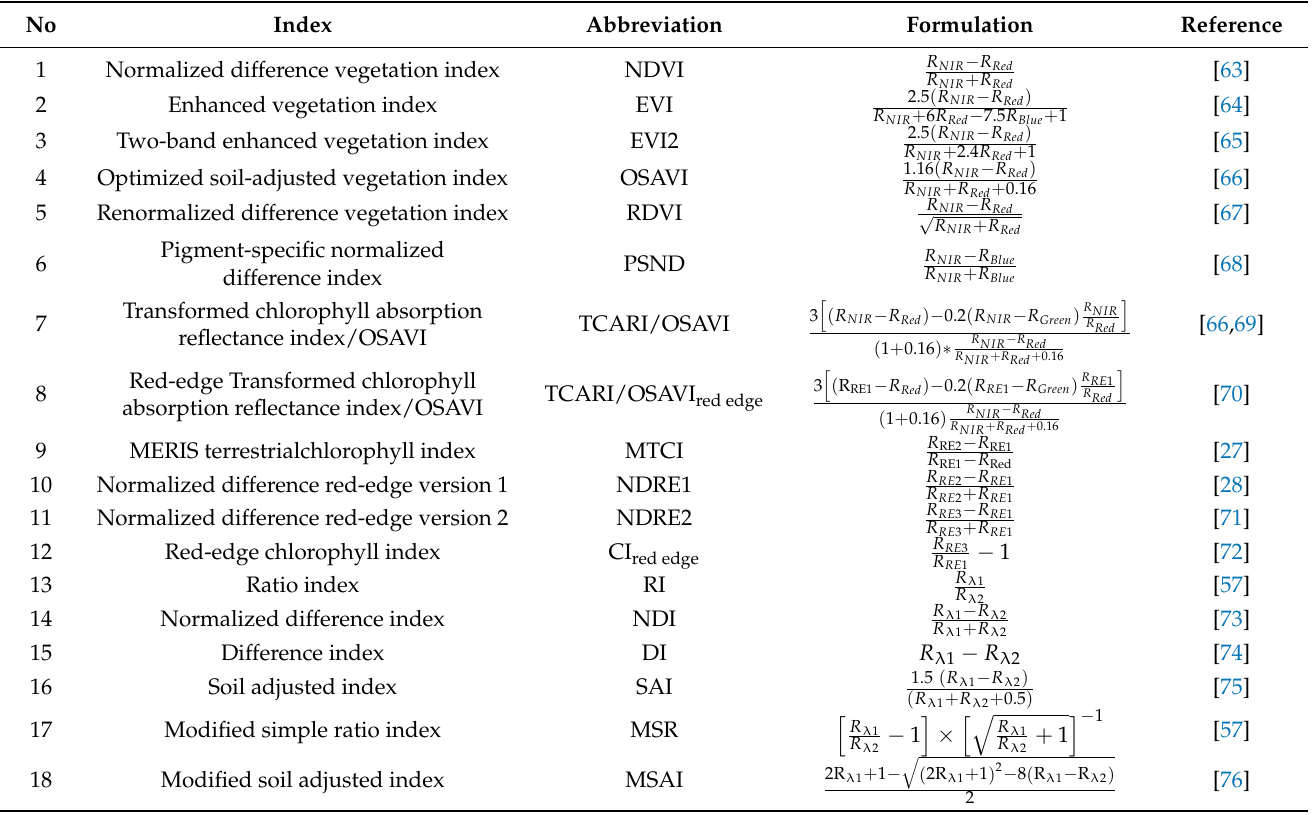
Table 2. The vegetation indices used in this study: indices 1–12 are existing indices with fixed wavelengths; 13–23 are general indices with wavelengths found by